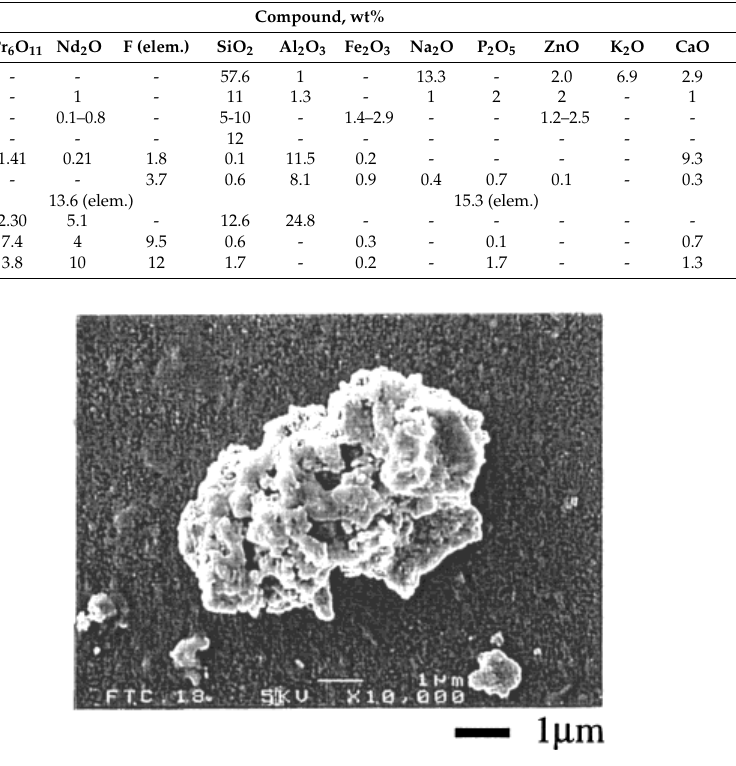
Figure 3. SEM image of a glass polishing waste sample shows fine particles. Reproduced from Kato et al. [12], with permission from American Chemical Society,